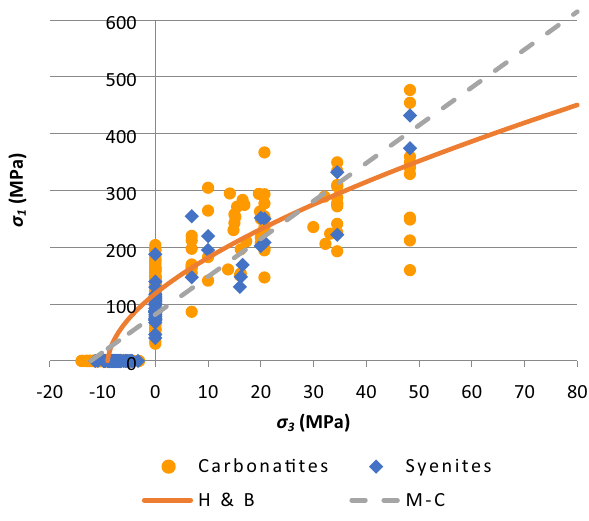
Fig. 7 The combined Hoek–Brown and Mohr–Coulomb failure envelopes for the carbonatite and the